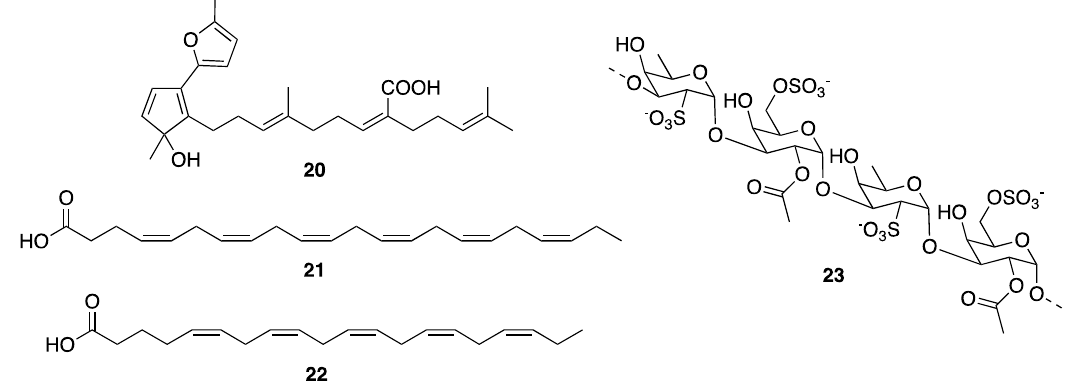
Figure 4. Structures of sargafuran ( 20 ), docosahexaenoic acid ( 21 ), eicosapentaenoic acid ( 22 ), and fucoidan ( 23 ).